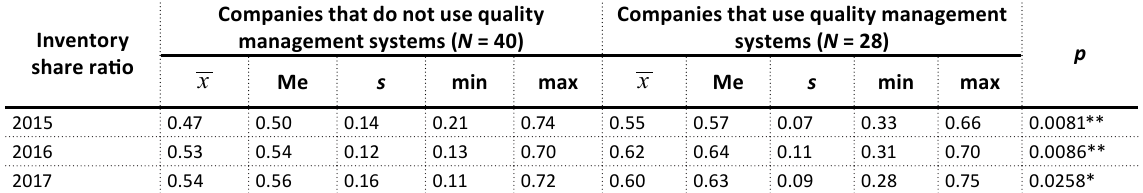
Table 1. Average results for the inventory share ratio in the analyzed